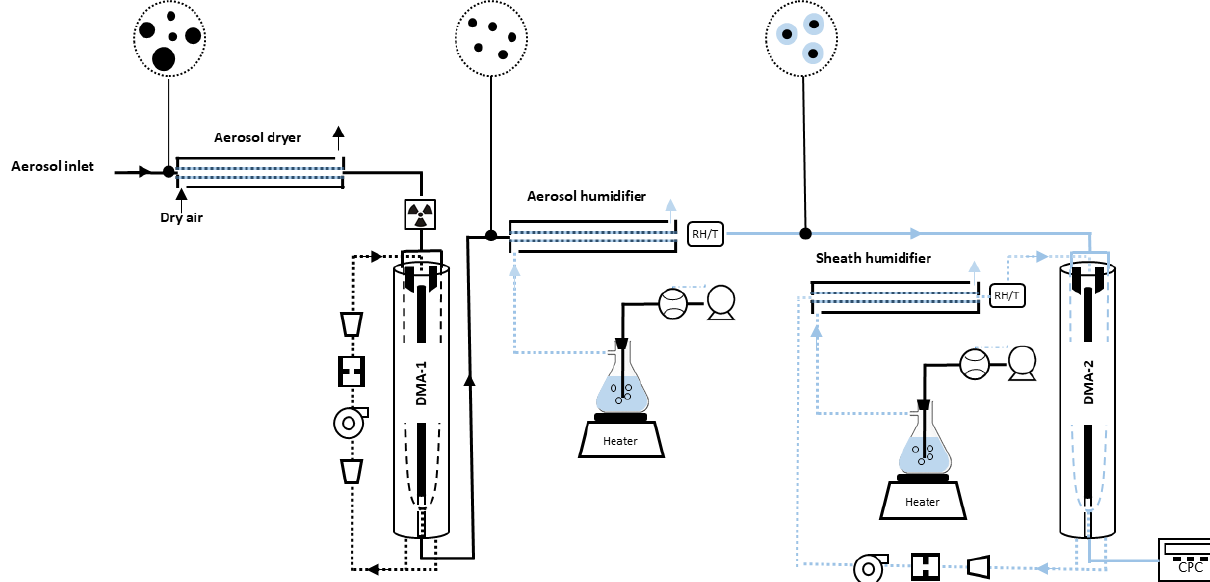
Figure 2. Schematic diagram of the HTDMA system.